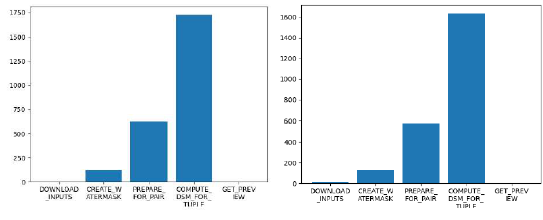
Figure 11: Average time by step in seconds: CNES HPC (left) and cloud (right) Figure 11 shows average time by step: downloading, watermask